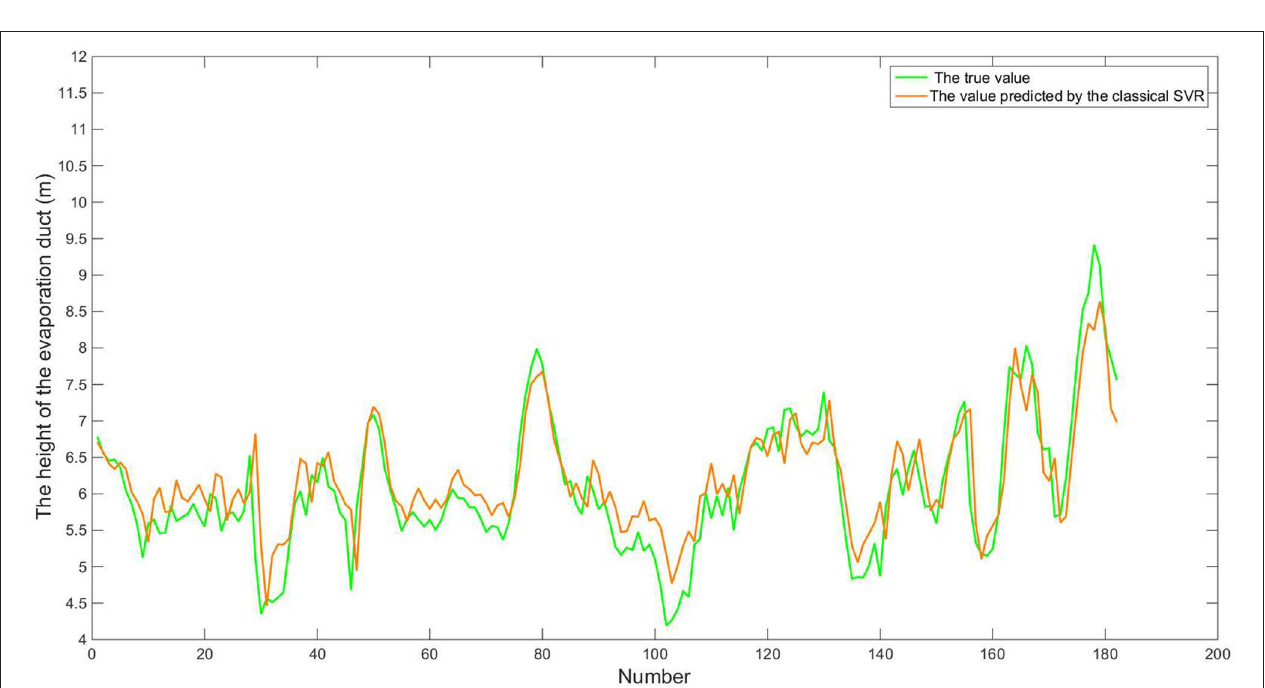
FIGURE 6 | Real values and values predicted by AR algorithm. The samples in the figure are from July 3, 2008 to December 31, 2019, which have 182 samples in total. Each sample in turn corresponds to the number 1–182 of the abscissa.